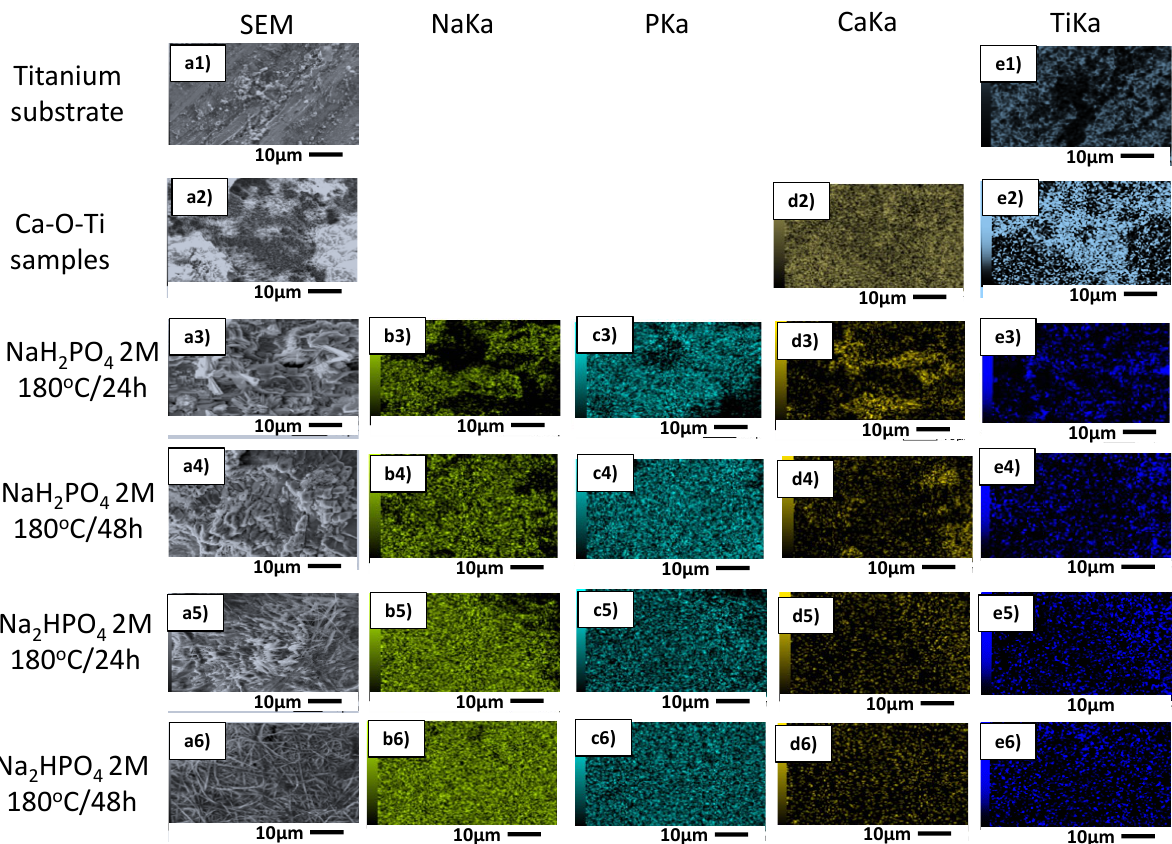
Figure 5. SEM and EDX images of ( a1 – e1 ) Ti substrate; ( a2 – e2 ) Ca–O–Ti samples, and when hydrothermally treated Figure 5. EDX images of ( a ) Ti substrate; ( b ) Ca–O–Ti samples, and when hydrothermally treated with different phosphate solutions; ( a3 – e3 ) NaH 2 PO 4 180 °C/24 h; ( a4 – e4 ) NaH 2 PO 4 180 °C /48 h; ( a5 – e5 ) Na 2 HPO 4 with different phosphate solutions. 180 °C /24 h and (a6-e6) Na 2 HPO 4 180 °C